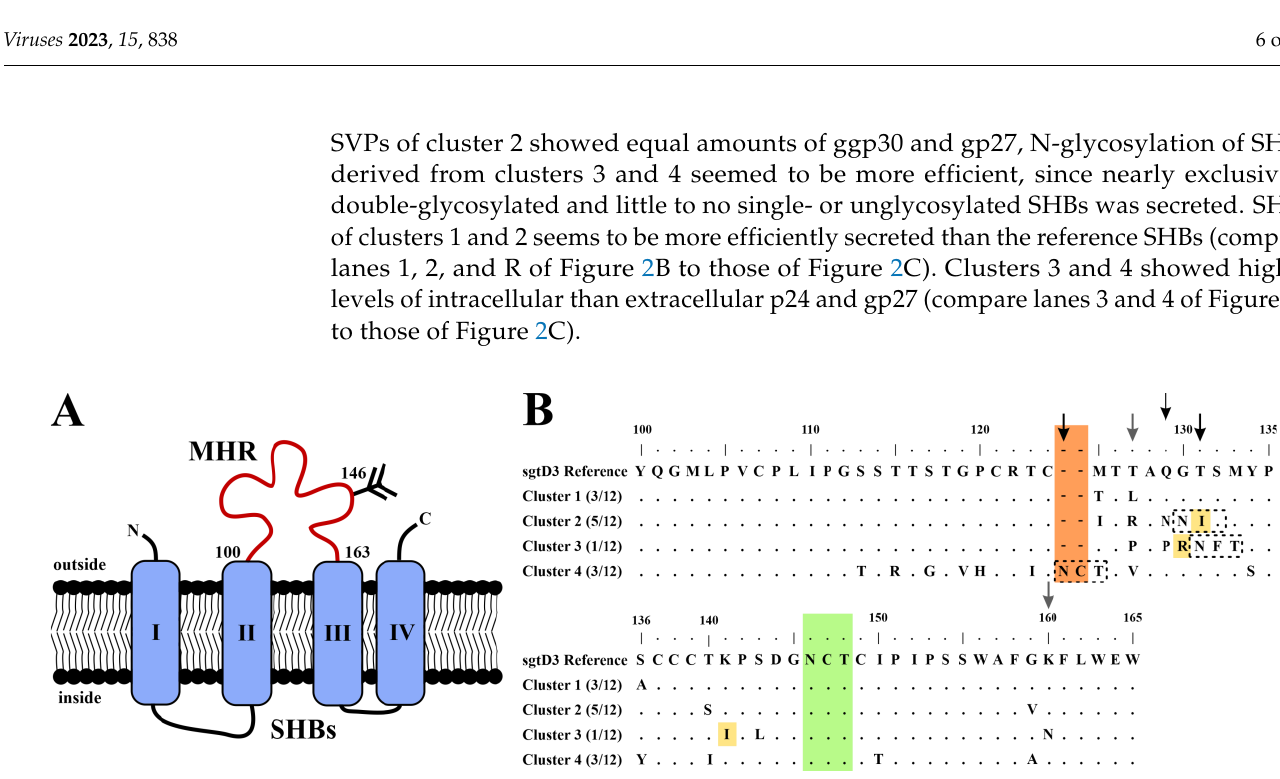
Figure 1. The major hydrophilic region (MHR) of mutated viral variants contains diagnostic escape mutations and additional glycosylation motifs. ( A ) The putative topology of SHBs. SHBs consists of four transmembrane domains. The MHR between transmembrane domains II and III (aa100-163) is the major target of neutralizing antibodies and is commonly associated with mutations. The N-linked glycosylation site at N146 is highly conserved. ( B ) MHR of serum-derived SHBs variants. Cluster 1 represents a subgenotype (sgt) D3 isolate (similar to the sgtD3 reference, serotype ayw3 ) but with an unusual ayw4 serotype, caused by mutation T127L. In the remaining clusters, several mutations were found: three previously described diagnostic escape mutations (cluster 2: T131I; cluster 3: G130R/K141I; yellow), a six-nucleotide insertion (cluster 4; orange), and substitutions introducing N-glycosylation motifs (clusters 2 – 4; boxed). The conserved N-glycosylation site (N146) is shown in green. Black arrows denote additional N-glycosylation sites. Grey arrows denote HBsAg subtype w / r determinant defining amino acids. Table 1. Mutations found in the variant sequences that are associated with diagnostic and/or immune escape in the S-ORF and their corresponding mutations in the overlapping RT/POL-ORF. Cluster